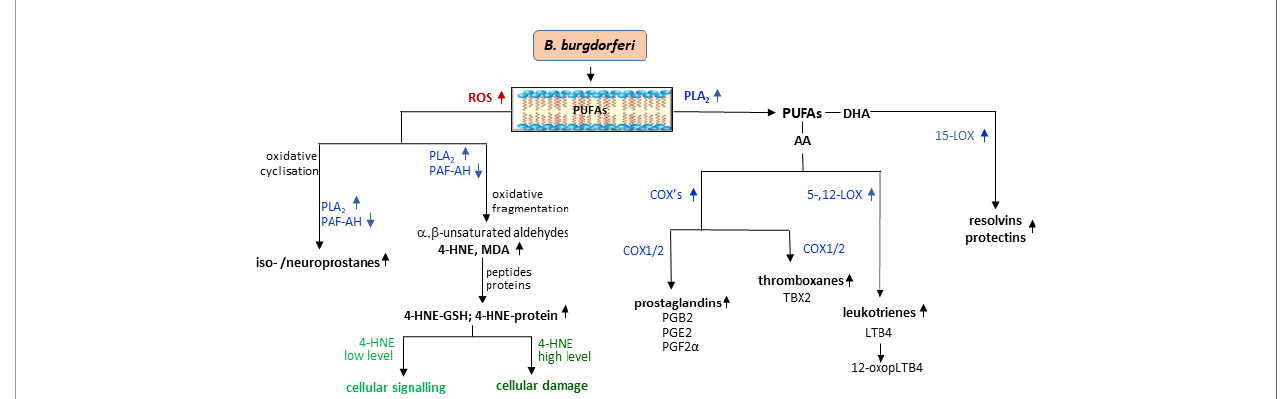
FIGURE 4 | Changes in phospholipid metabolism with lipid mediators generation during B . burgdorferi